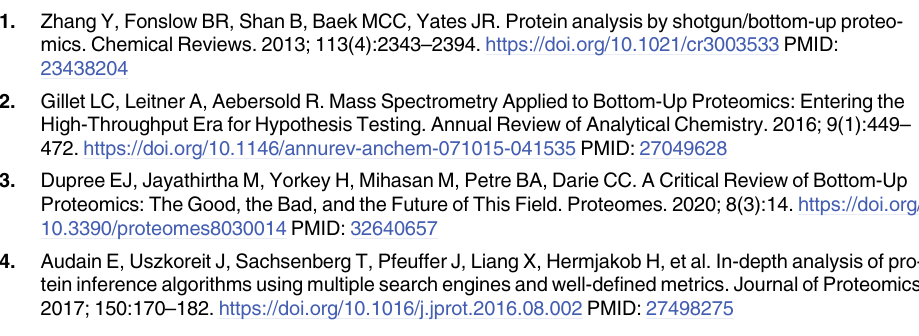
rightmost bar with the label “10+” comprises the values of 10 and above. (PDF) S3 Fig. Representative bipartite graphs of the ten largest isomorphism classes found in data set D2. (a) D2_fasta, (b) D2_quant, with number of occurrences and percentage of all graphs. S4 Fig. Representative bipartite graphs of the ten largest isomorphism classes found in data set D3. (a) D3_fasta, (b) D3_quant, with number of occurrences and percentage of all graphs. S5 Fig. Representative bipartite graphs of the ten largest isomorphism classes found in data set D3_iso. (a) D3_iso_fasta, (b) D3_iso_quant, with number of occurrences and per- centage of all graphs.